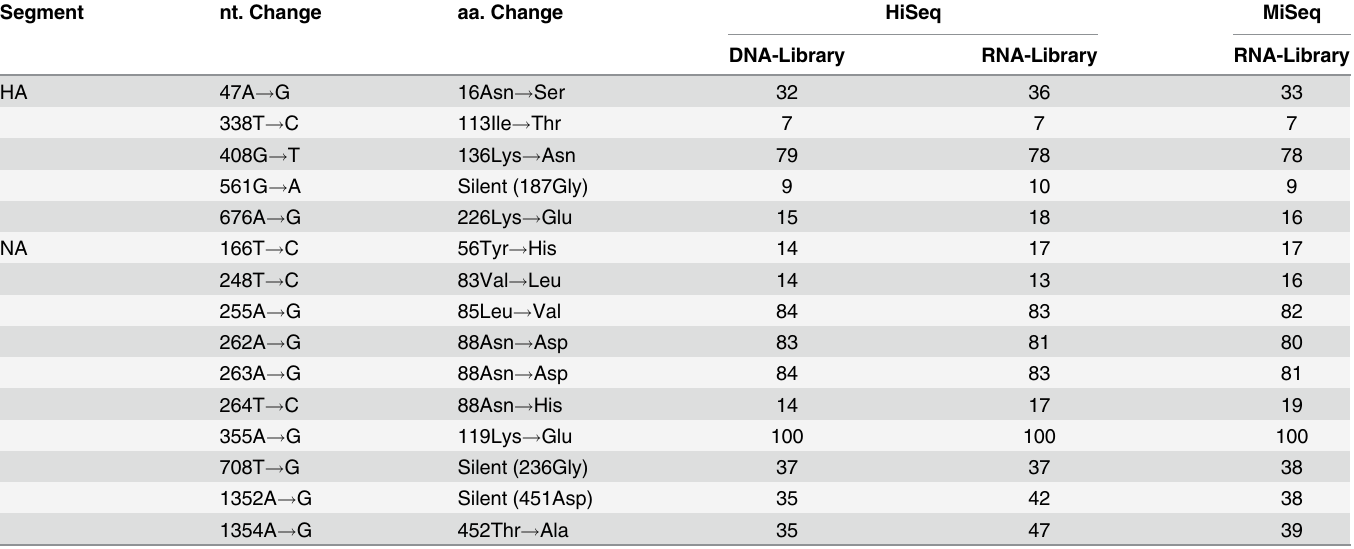
Table 5. Mutation percentages ( (cid:3) 5%) emerged in HA and NA of 121XP-M4 virus passaged in eggs. Note: These mutation percentages were calculated per comparison with the corresponding expanded wild-type progenitor. (See accession numbers in Materials and Methods.) aa: Amino-acid, nt: Nucleotide.